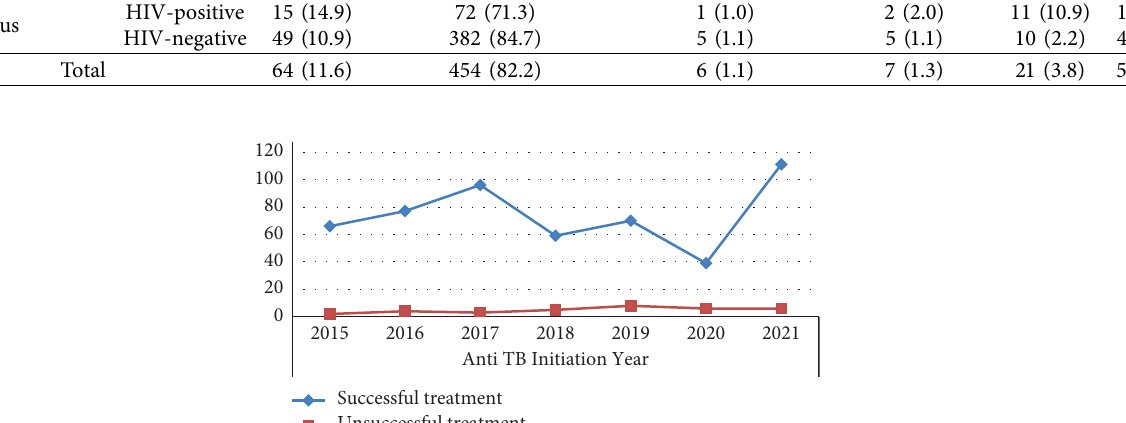
Figure 2: Trend of successful TB treatment outcomes of TB patients at Tefera Hailu Memorial General Hospital, Sekota, Northeast Ethiopia from 2015 to